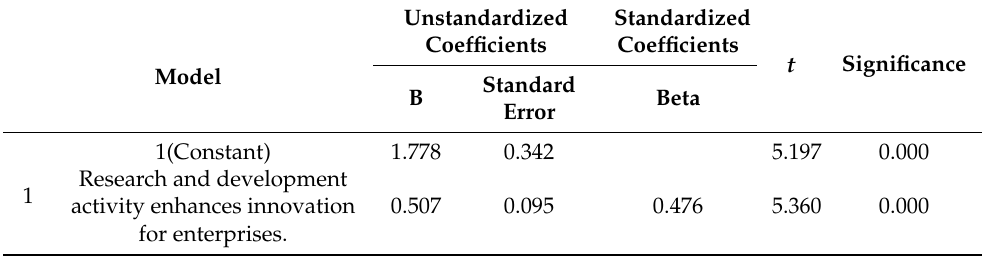
Table 6. The unstandardized and standardized coefficients for hypothesis H2.